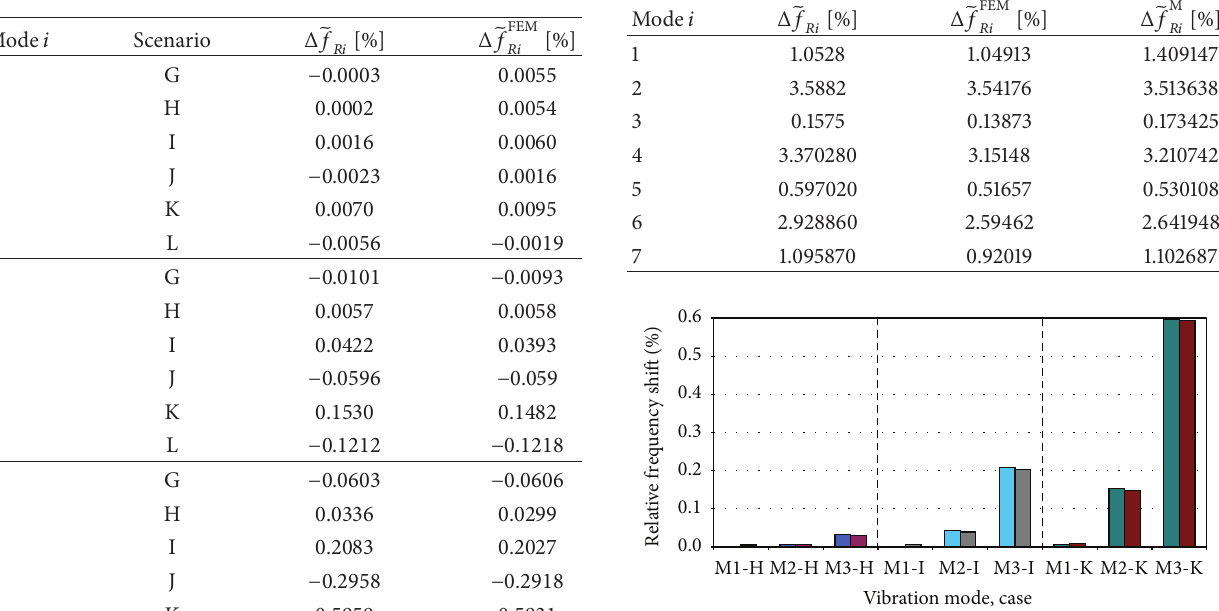
Figure10:Therelativefrequencyshiftsanalyticallyderived(leftbars for each mode) and evaluated by FEA (bars positioned at right) for the mass decrease on a narrow